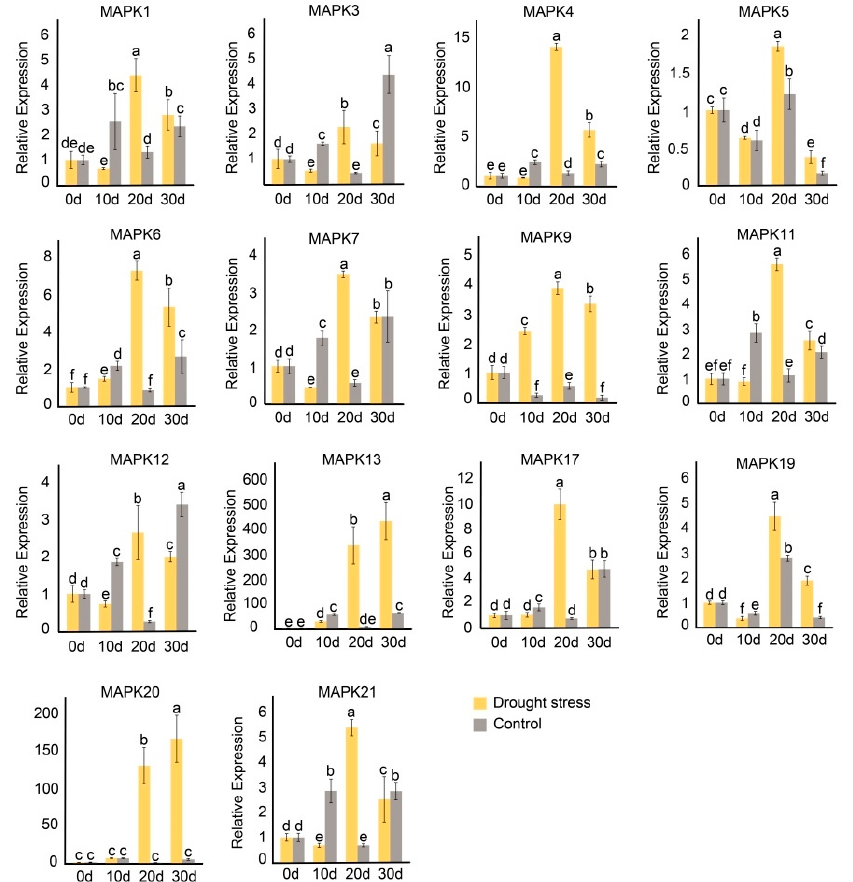
Figure 8. Expression pattern of the JrMAPK genes under drought treatment. Error bars are standard deviations from the biologic replicates. Bars with different letters in each panel are significantly different at p < 0.05, based on one-way ANOVA and Tukey’s test.